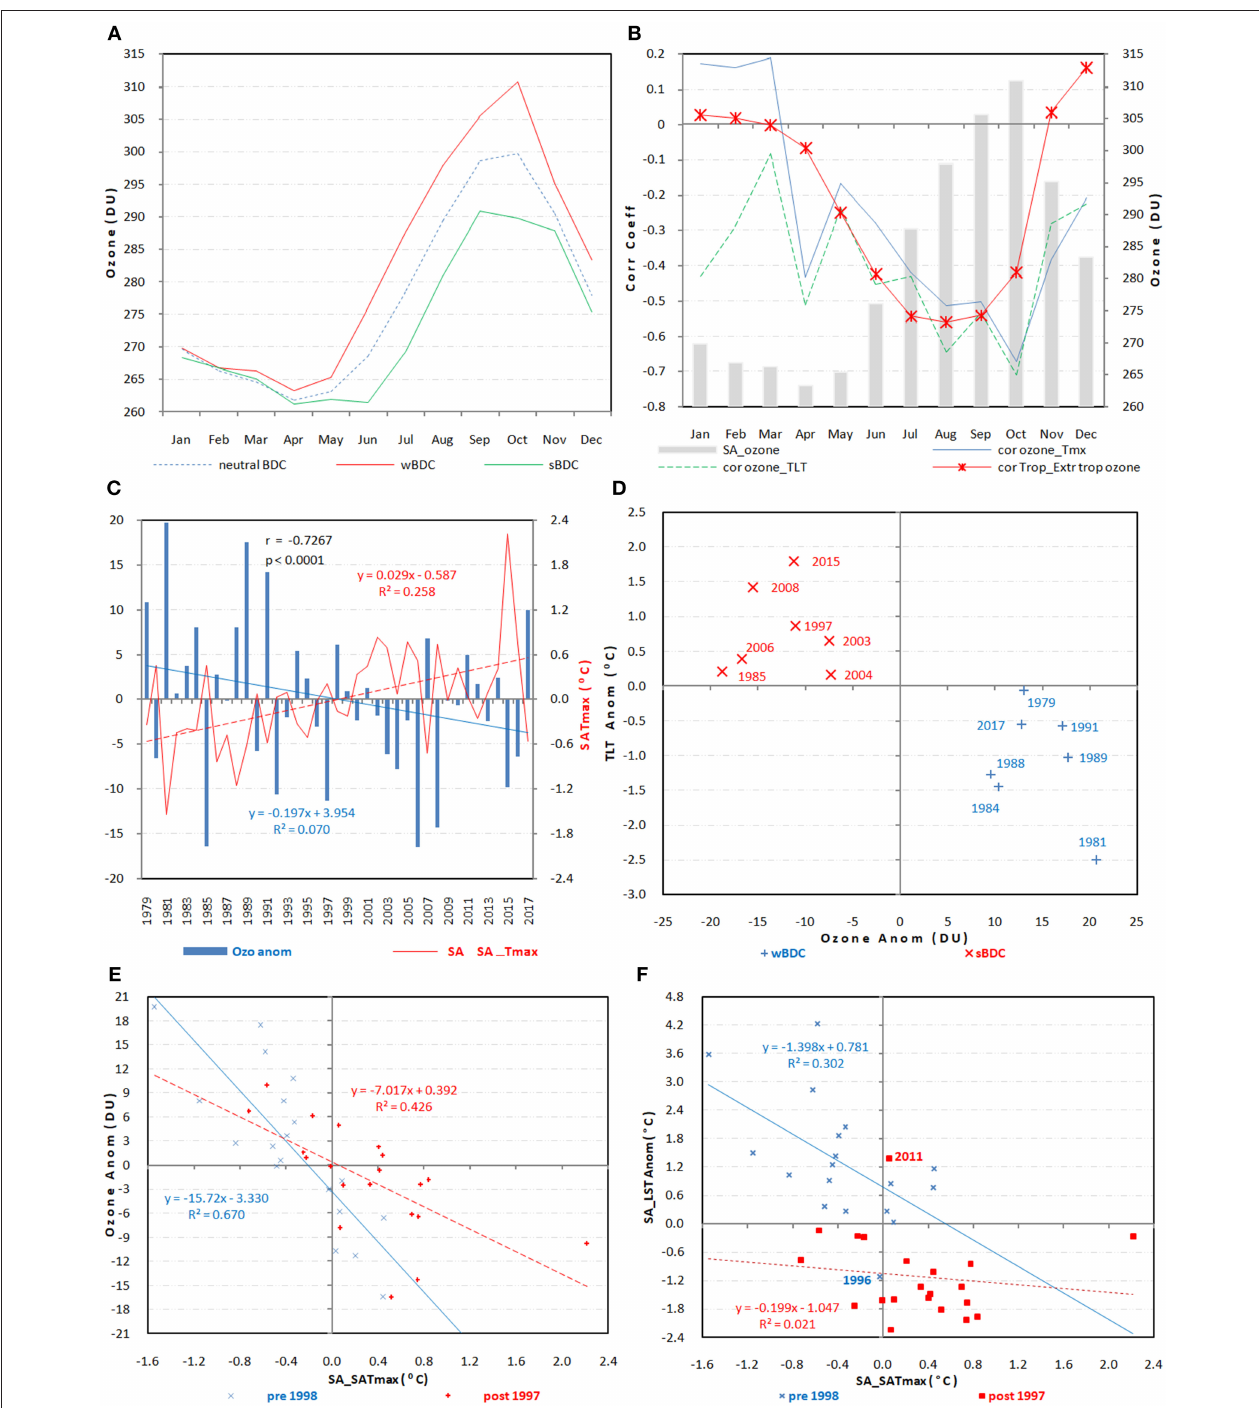
FIGURE 3 | Monthly (A) SA_ozone anomalies related to the wBDC, sBDC, and neutral BDC composites and, (B) correlation values between SA_ozone and SA_SATmax (blue line), SA_ozone and SA_TLT (green line) that is superimposed on the monthly correlated values between the tropically and subtropically averaged ozone (red line with asterisks). In the background are the monthly ozone values for the wBDC composite (gray bars). (C) Temporal manifestation of SA_ozone anomalies alongside that of SA_SATmax with the corresponding regression lines superimposed. (D) October scatter plot for SA_TLT anomalies ( ◦ C) against SA_ozone anomalies (DU) for the wBDC (blue crosses) and sBDC (red crosses). The scatterplot for (E) SA_SATmax against SA_ozone and (F) stratospheric temperature anomalies against SA_SATmax. In the inserts of the figures are the regression line equations. The data is for the post satellite period of 1979 to 2017.